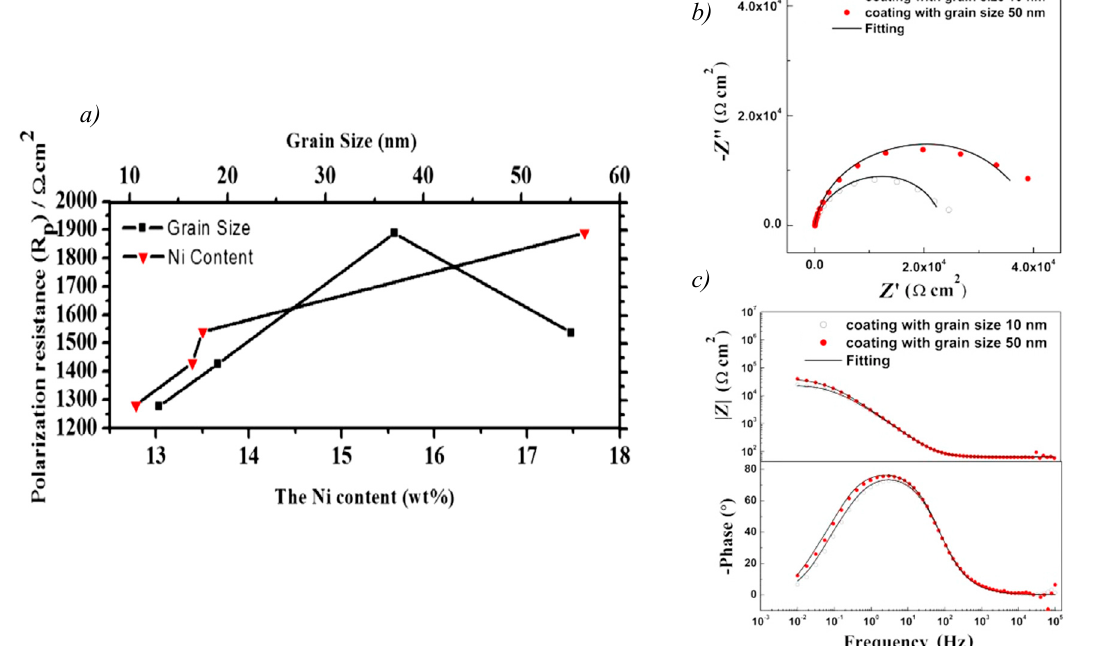
Figure 8. Effect of grain size on the nanoscale. ( a ) Highest polarisation resistance obtained with an intermediate grain size of NC Zn–Ni alloy of different nickel content [48]; ( b , c ) Higher impedance and phase values for the higher grain size for coated Q325 steel [59].